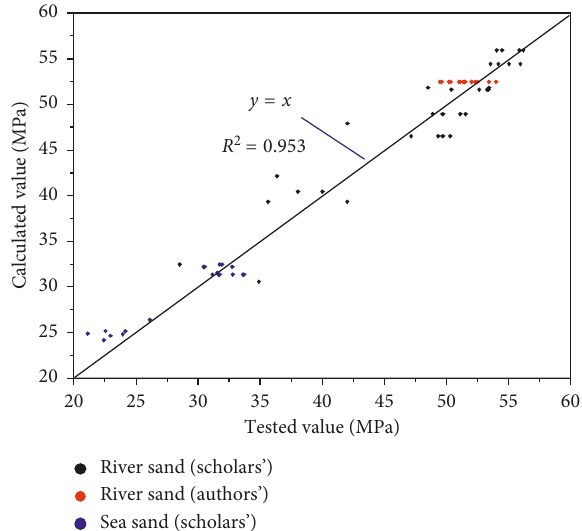
Figure 13: Comparison of calculated values and tested values of f . cu , 28